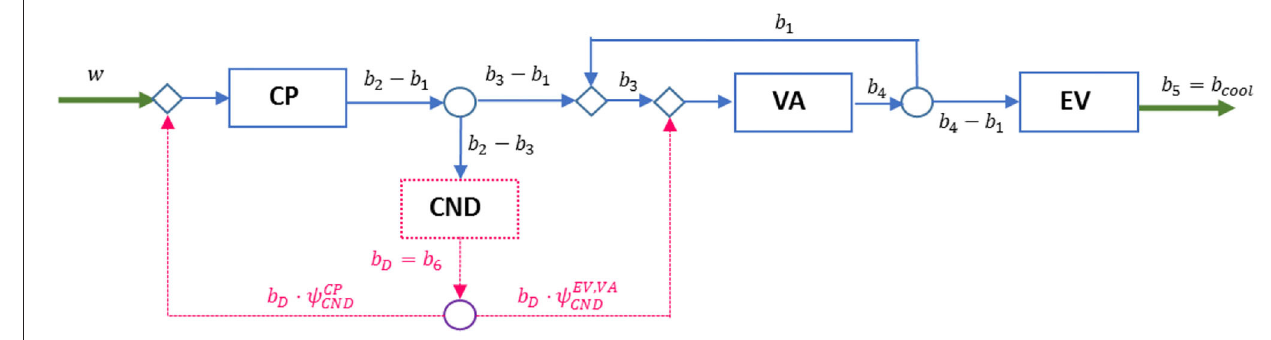
FIGURE 2 | Condenser as a unique dissipative component.